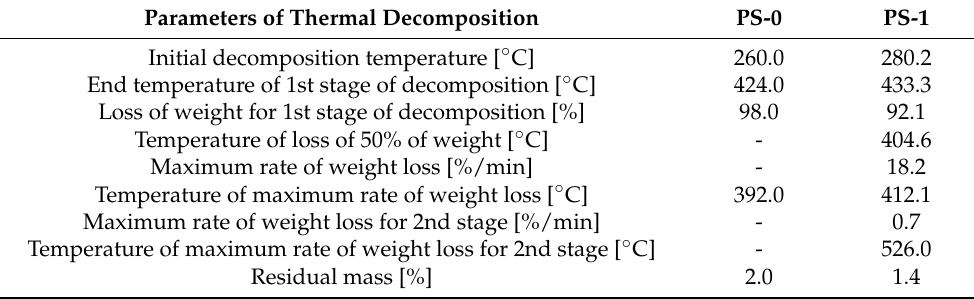
Table 3. Selected parameters for the thermal decomposition process for polystyrene.